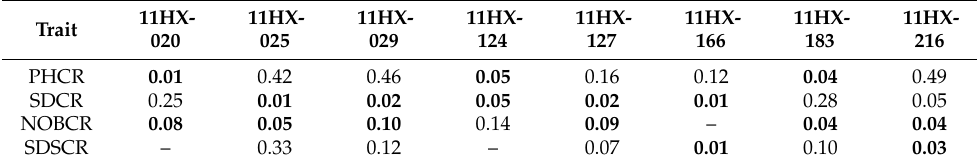
Table 2. Accessions with a stable phenotype under normal and low-light conditions. 11HX- 11HX- 11HX- 11HX- 11HX- 11HX- 11HX- 11HX- Trait 020 025 029 124 127 166 183 216 PHCR 0.01 0.42 0.46 0.05 0.16 0.12 0.04 0.49 SDCR 0.25 0.01 – – 0.33 0.12 – 0.07 0.01 0.10